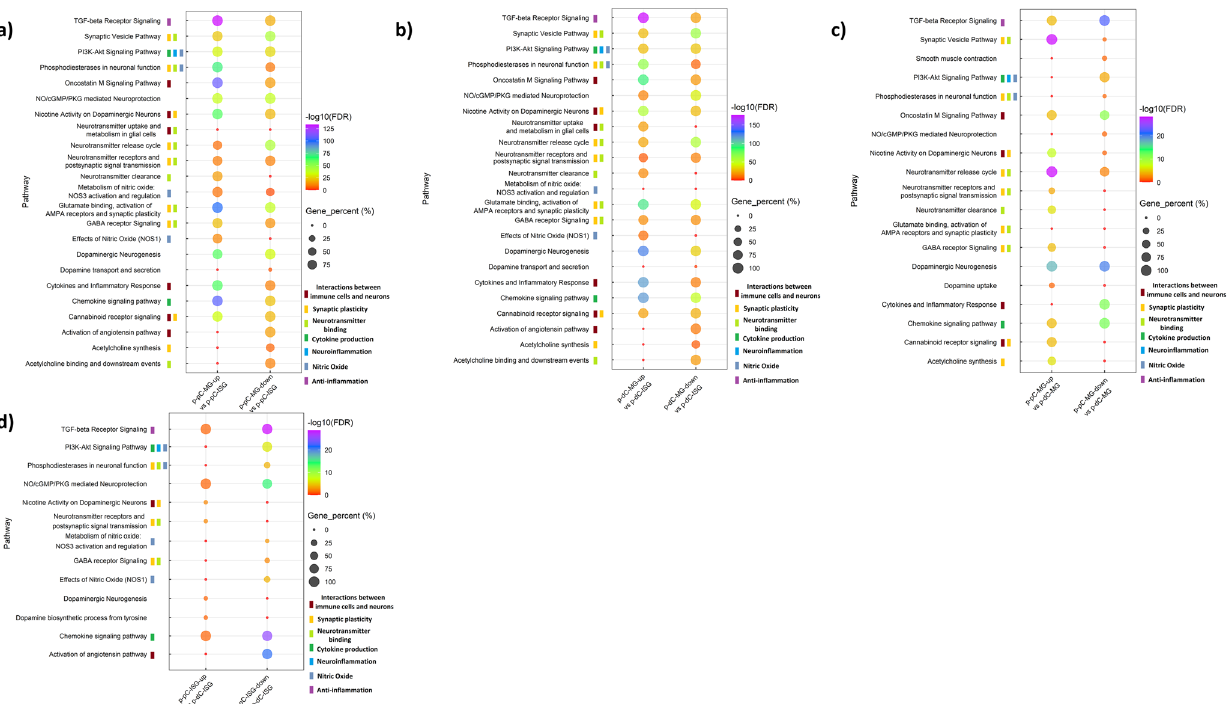
Fig. 3 Preferential enrichment for genes associated with functions of myenteric and inner submucosal ganglia (MG, ISG) in porcine proximal or distal colon (p-pC, p-dC). Comparison of pathway enrichment between MG and ISG in p-dC or p-dC a , b , and in MG or in ISG between p-pC and p-dC c , d . The bubble plots show the gene percentage and enrichment of WikiPathways. Circle size represents the ratio of the number of pathway-speci fi c differentially expressed genes (DEG) and the number of total DEG in each DEG list (Gene_percent). Color represents a -log10(FDR) distribution from big (orange) to small (purple). The color bars mean the speci fi ed WikiPathways classi fi ed into designated clusters. Up, upregulated expression. Down, downregulated